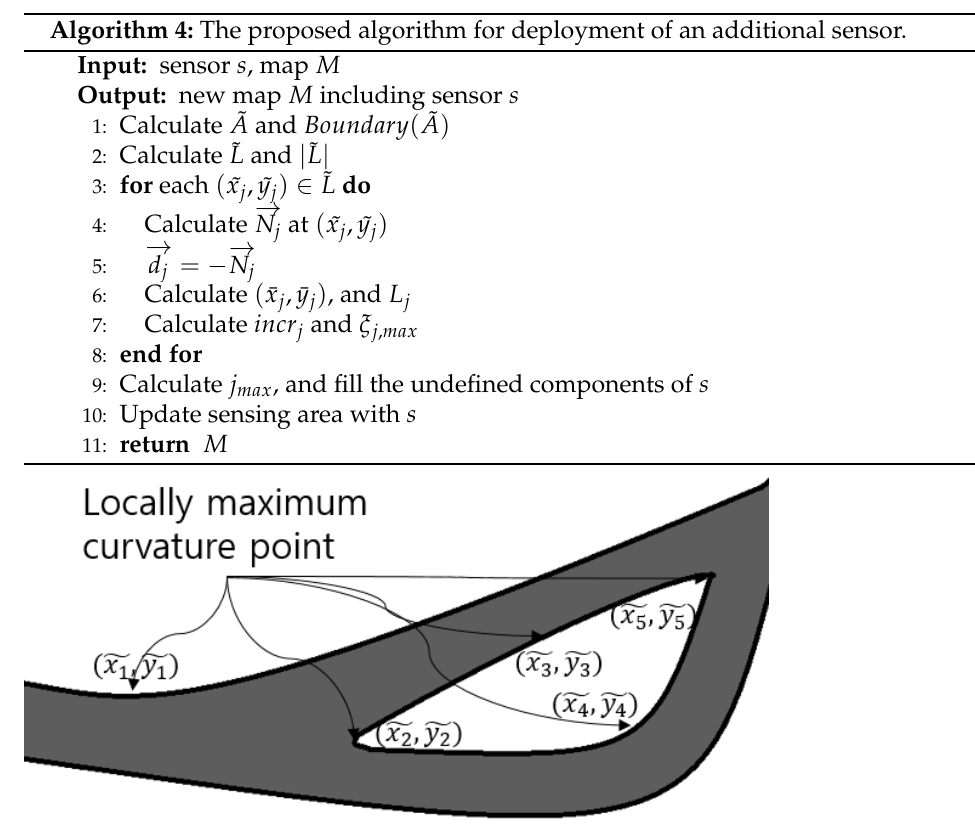
Figure 12. ( ˜ x j , ˜ y j ) is one of the point at which the curvature is a local maximum in given ˜ A